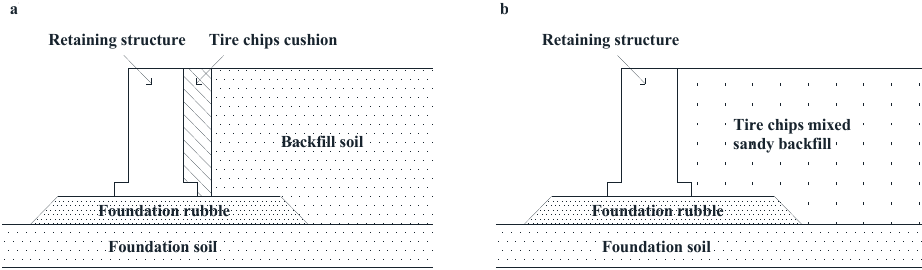
Figure 9. Tire chips used to protect retaining structure: ( a ) as a cushion or ( b ) as an additive to be mixed evenly in the backfill (Modified from [64,65]).